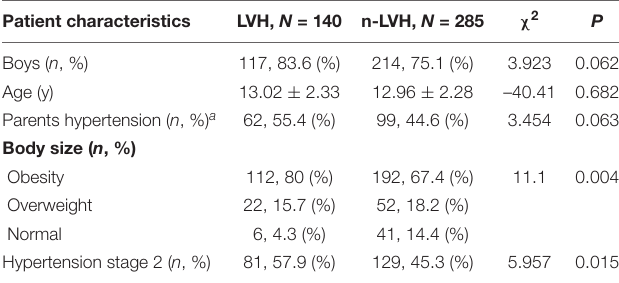
TABLE 1 | Characteristics of left ventricular hypertrophy (LVH) group and n-LVH group. Patient